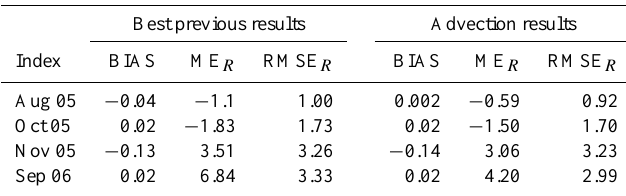
Table 3. Comparison of results before and after applying the advec- tion correction.